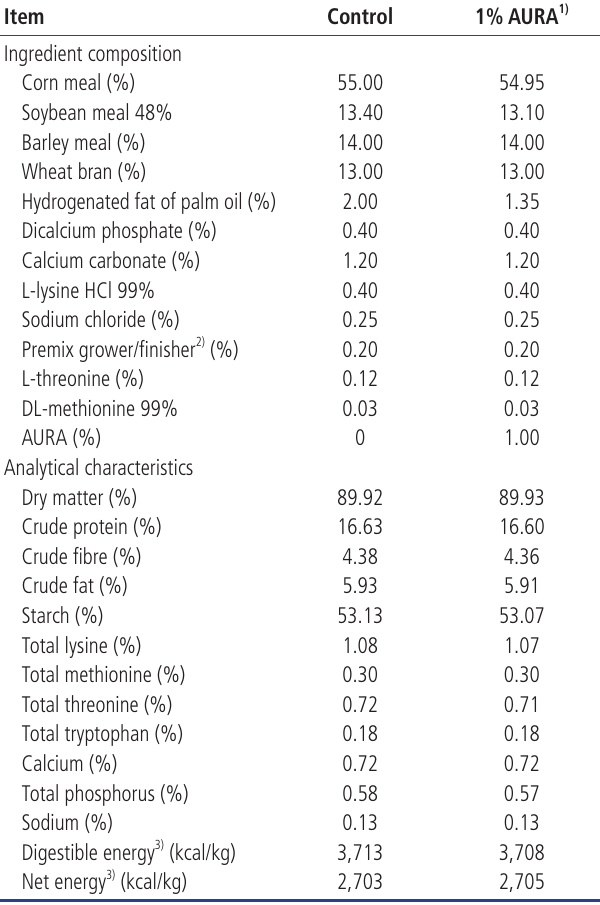
Table 1. Ingredient composition (%) and calculated analysis of the control and docosahexaenoic acid-rich microalgae (AURA) diets